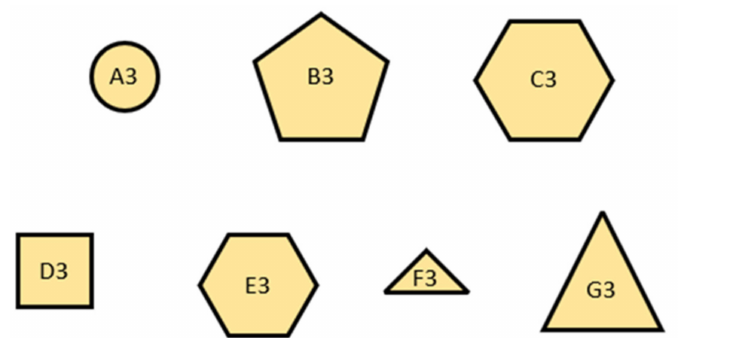
Figure 4. The second set of graphics.